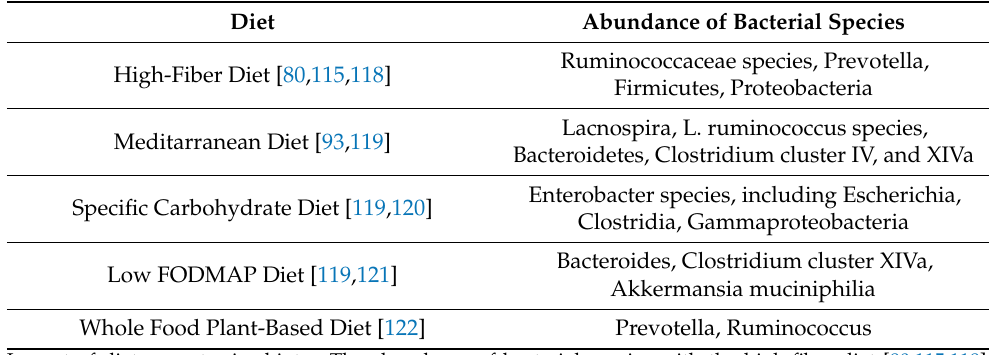
Table 4. Impact of diet on gut microbiota. Diet Abundance of Bacterial Species High-Fiber Diet